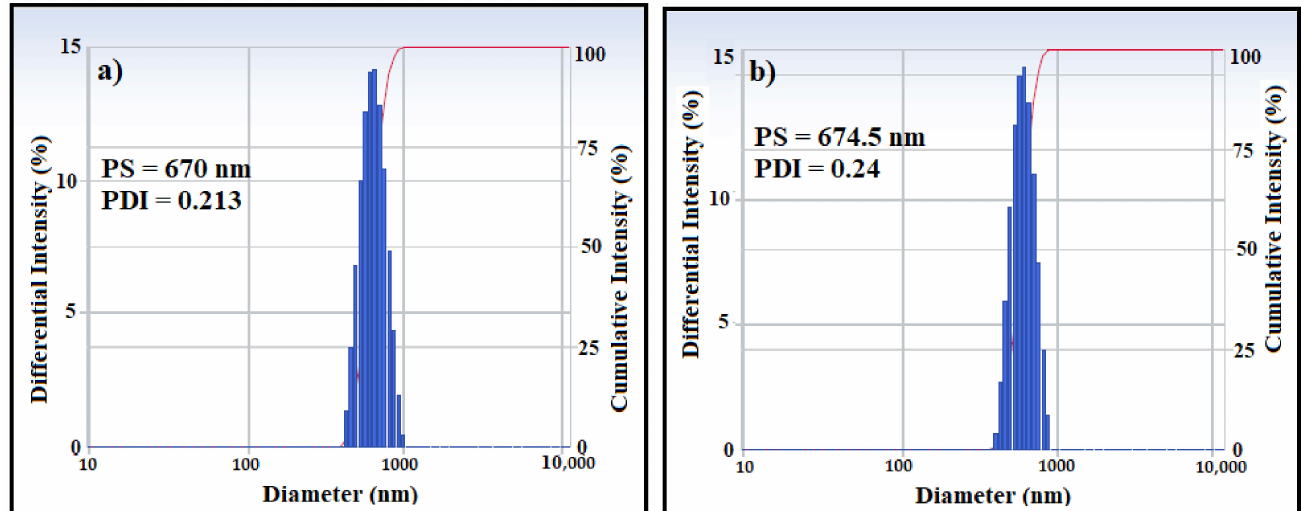
Figure 6. Particle size distribution of ( a ) OA-MNPs and ( b ) DA-MNPs.